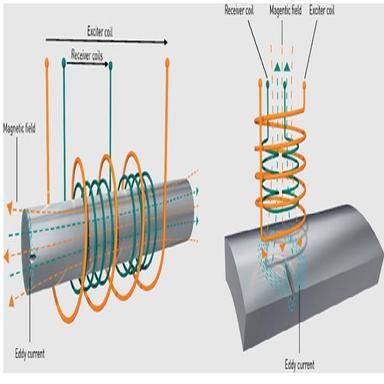
Formation of eddy currents on metallic surfaces.